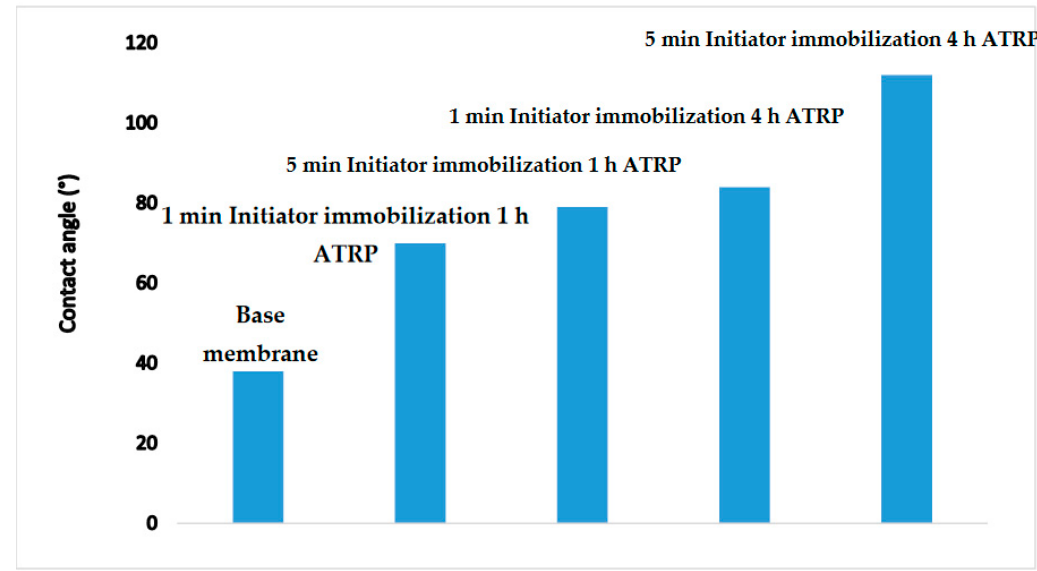
Figure 3. Water contact angles (°) for the base and modified membranes (error within ±5°).